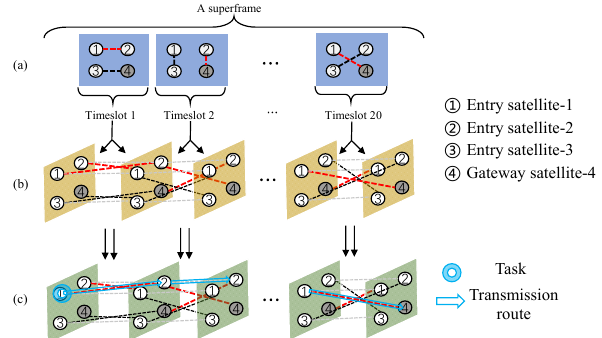
Figure 2. Inter-satellite routing network structure. (a) Inter-satellite link schemes within each time slice; (b) Inter-satellite link schemes in space-time networks; (c) Routing schemes based on inter- satellite topologies